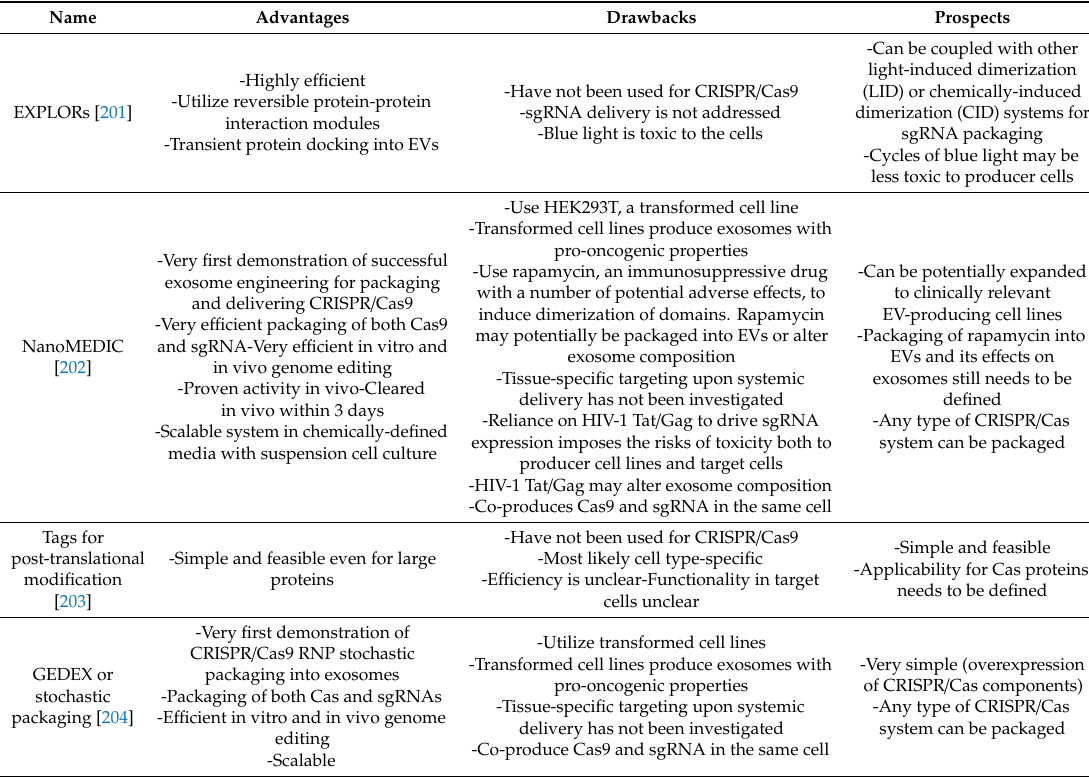
Table 2. Characteristics of molecular tools and mechanisms for loading Cas proteins into